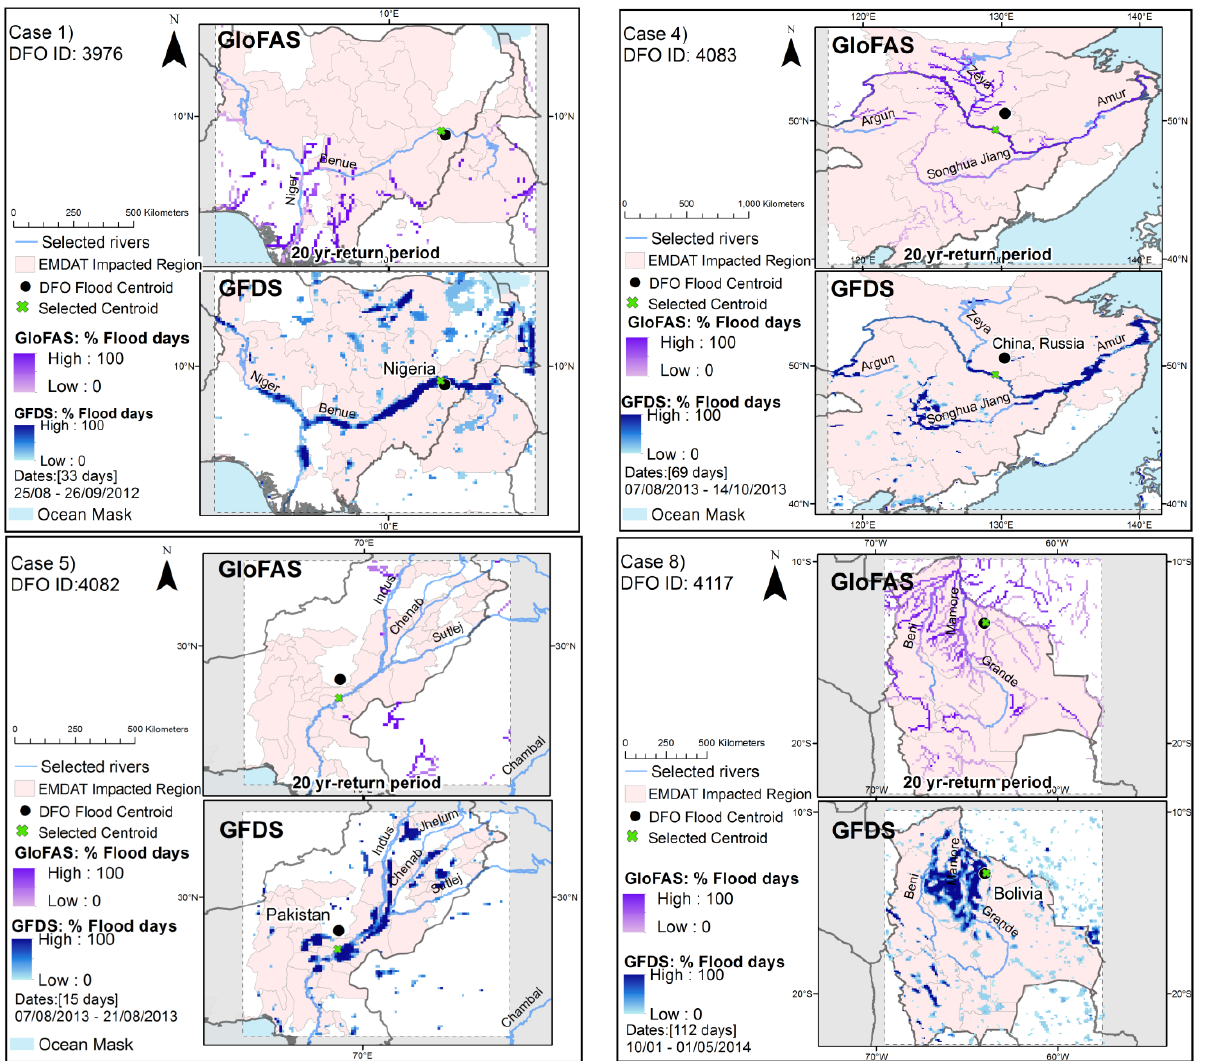
Figure 3. Total number of detected/forecasted (one-day lead for GloFAS) flood days expressed as the percentage of the total duration of flood. The flood cases shown are from Nigeria (2012), China and Russia (2013), Pakistan (2013), and Bolivia